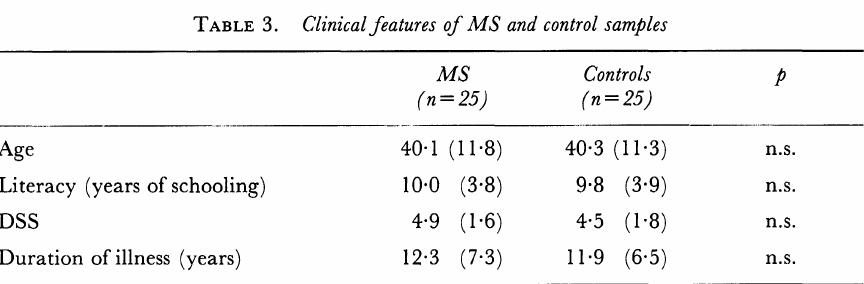
TABLE 3. Clinical features of MS and control